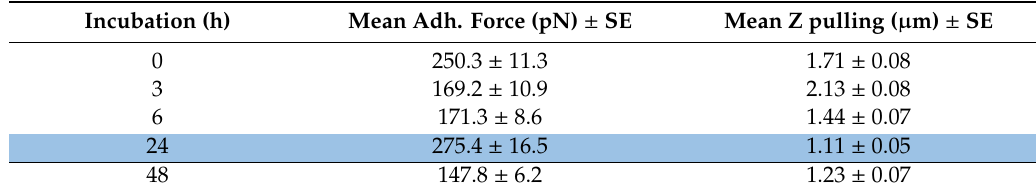
Figure 3. Histogram and boxplot distribution of the measured ( top ) maximum adhesion force values and ( bottom ) Z pulling distance to the maximum force for MCF-7 cells ( N > 90) upon exposure to 50 µ M resveratrol at di ff erent control points. The square ( (cid:3) ) in the box plot represents the mean value, while the box-splitting horizontal line gives the median. A full statistical comparison between values is shown in Table S1 (Supporting information). Table 2. Temporal mean maximum adhesion force and the correlated Z displacement for MCF-7 cells ( N > 90) upon exposure to 50 µ M resveratrol. The blue box highlights extreme values obtained at t = 24